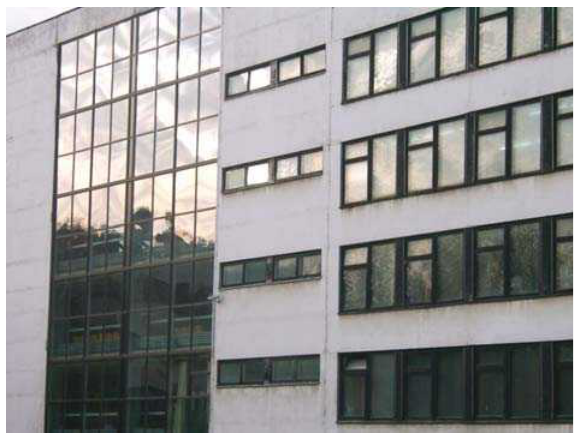
Fig 4. Fragment of KTU Faculty of Chemical